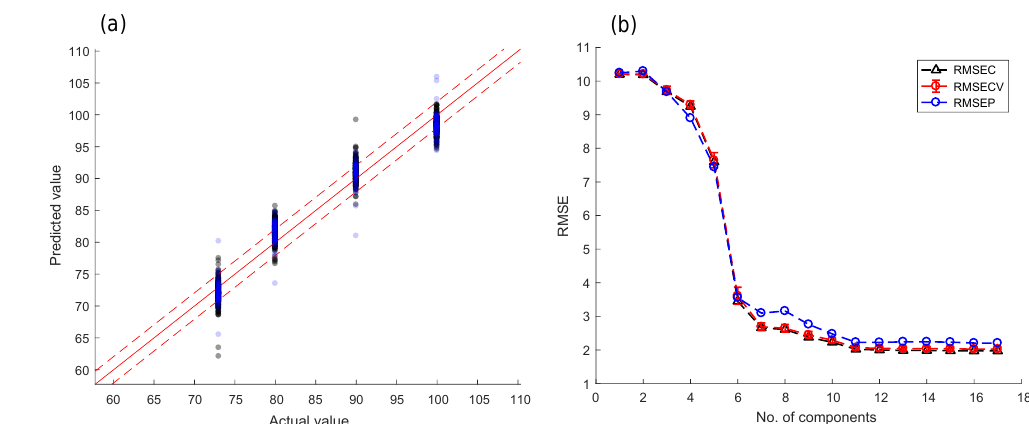
Figure 16. (a) PLSR model of the valve fault with an RMSE of 2 (dashed lines), where the optimal number of components was determined with the error/component graph in (b)